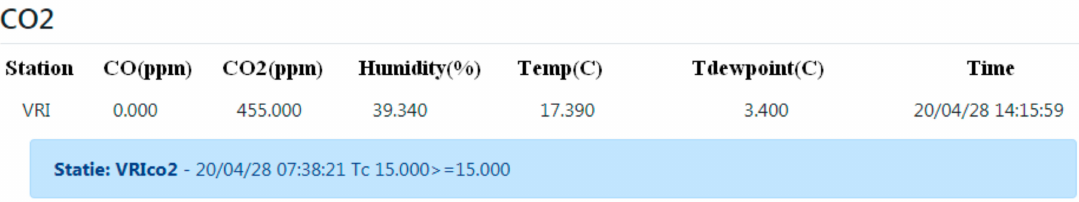
Figure 14. Information on http://geobs.infp.ro/ web platform in real